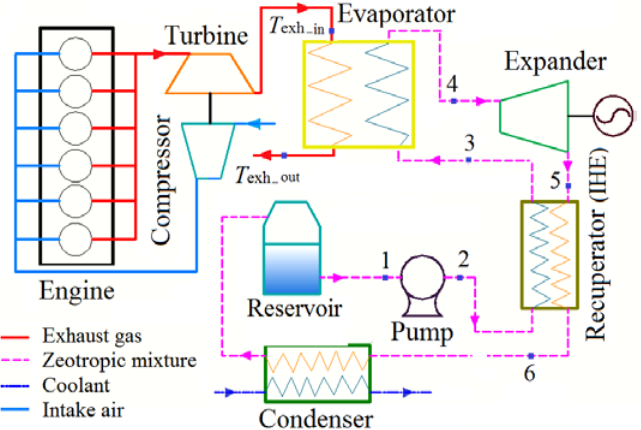
Figure 1. Schematic diagram of the organic Rankine cycle (ORC) waste heat recovery system. IHE: internal heat